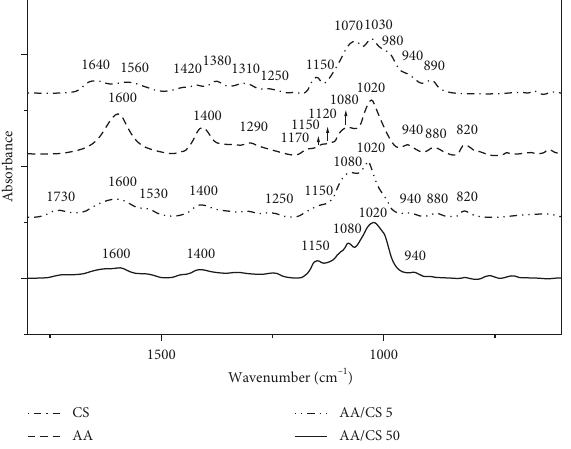
Figure 15: FTIR spectra from CS, AA, AA/CS ratio 5, and AA/CS ratio 50.